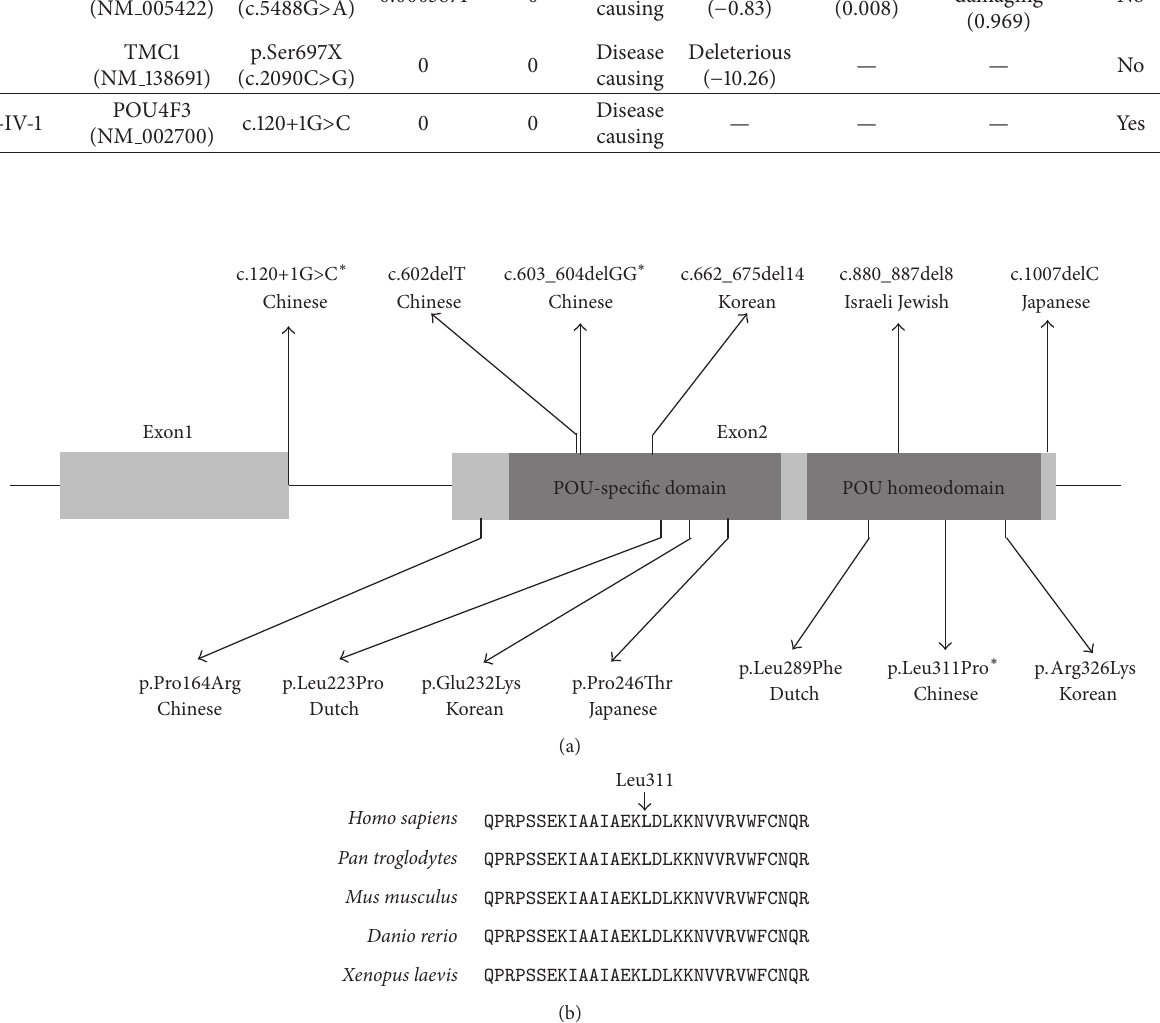
Figure 2: Summary and conservation of the POU4F3 mutations. (a) Schematic illustration of the thirteen reported POU4F3 mutations associated with DFNA15. Asterisks indicated the mutations reported in the present study. (b) Multispecies sequence alignment showing the evolutionary conserved amino acid